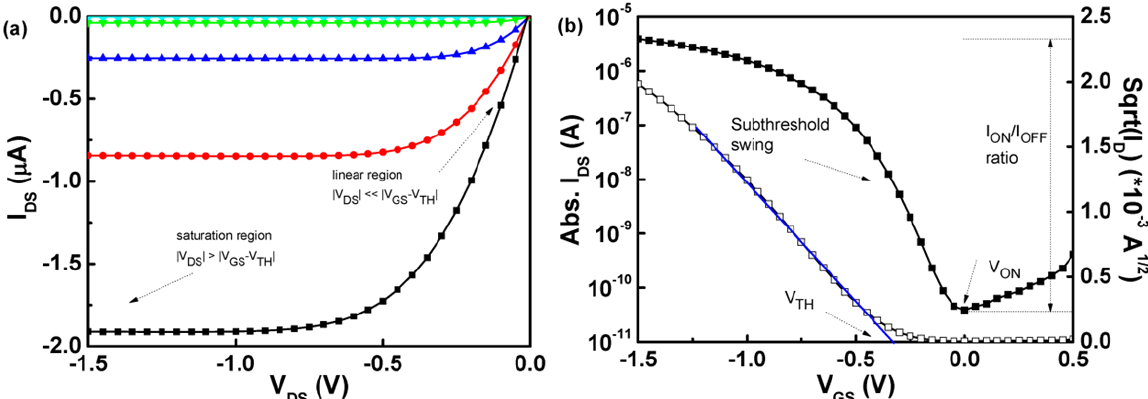
Figure 3: Typical output and transfer characteristics of p-type TFTs